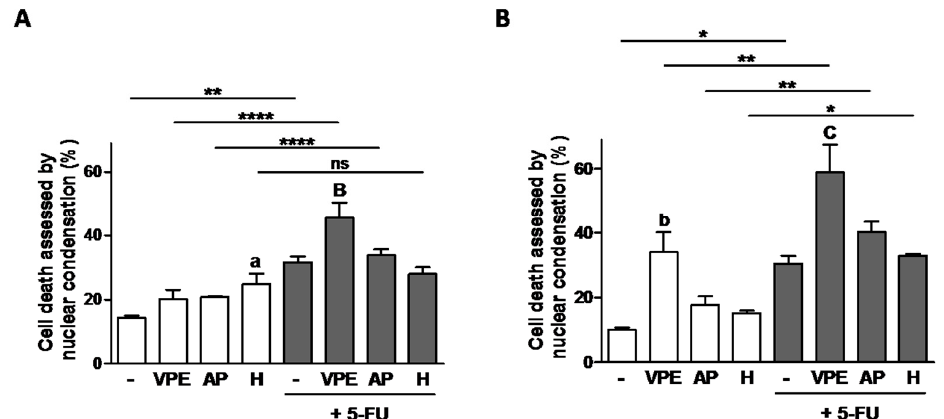
Figure 5. E ff ect of 48 h exposure to VPE, apigenin (AP), and hesperidin (H), alone and in combination with 5-FU on cell death of HCT116 ( A ) and RKO ( B ) cells, as evaluated by the nuclear condensation assay. Cells were pre-incubated with the VPE (IC 25 ) and corresponding concentrations of AP, or H (see Table 3) for 48 h, followed by co-incubation with 5-FU (IC 25 ) for further 48 h ( A & B ). Cells that were not pre-treated were only exposed to 5-FU for 48 h. Values are expressed as mean ± SEM of three independent experiments. Letters and symbols represent statistical significance: a p ≤ 0.05, b p ≤ 0.01 when compared with control; B p ≤ 0.01, C p ≤ 0.001 when compared with 5-FU; ns p > 0.05, * p ≤ 0.05, ** p ≤ 0.01, **** p ≤ 0.0001 when compared with respective extract / compound by two-way